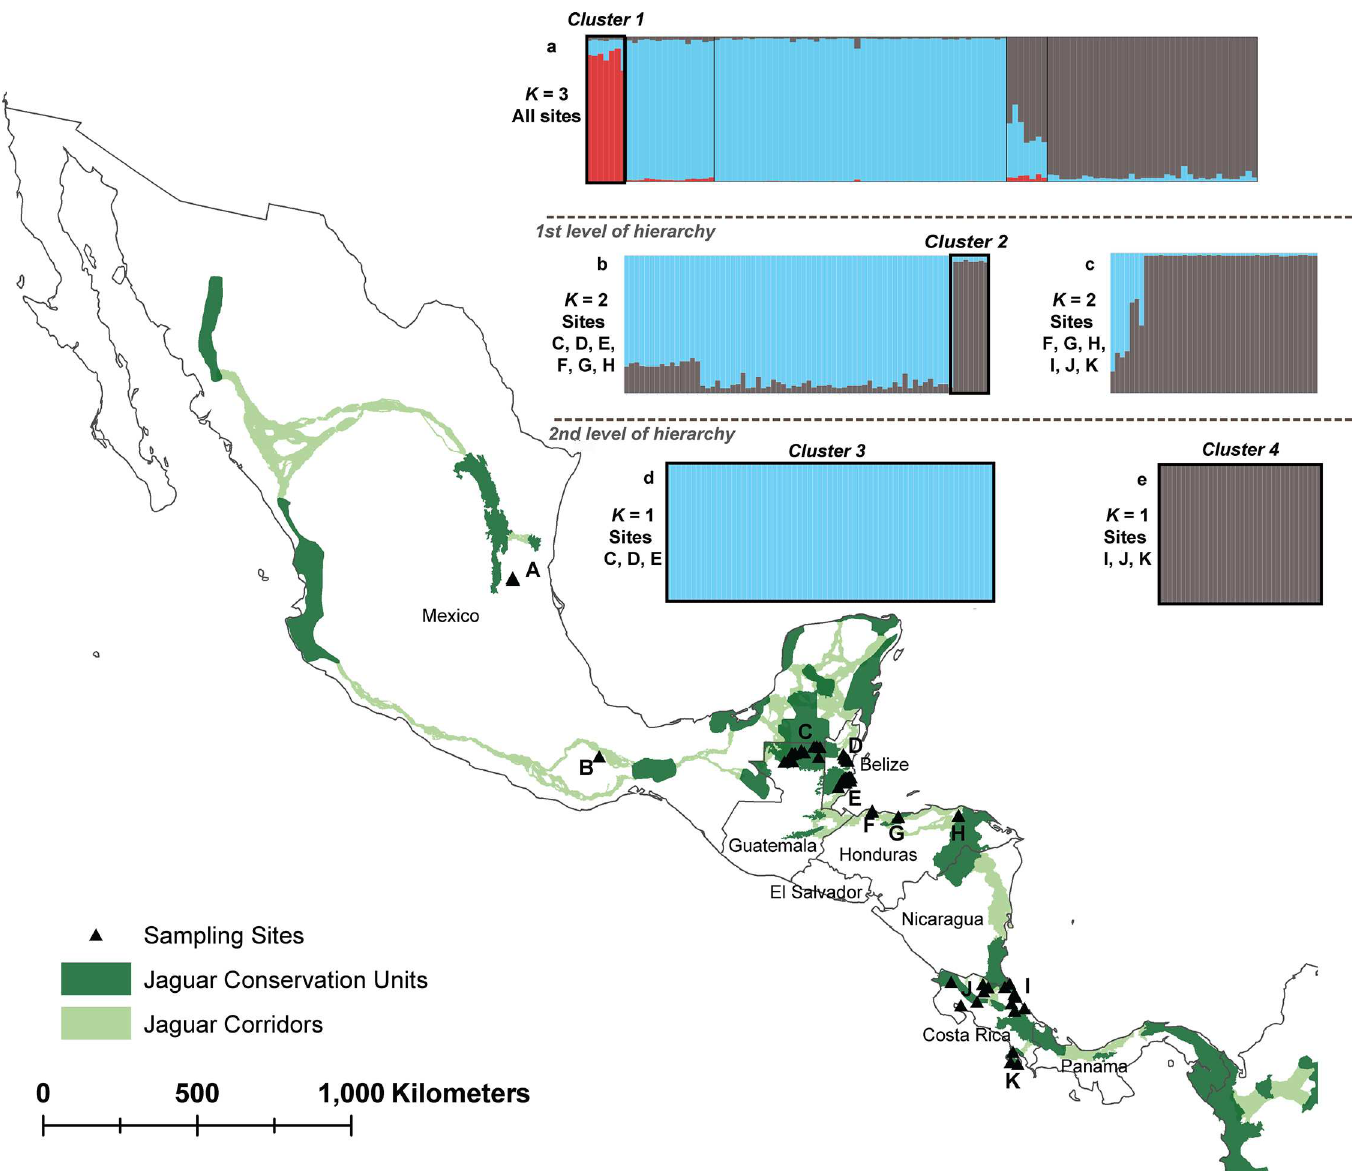
Fig 4. Hierarchical genetic structure in Mesoamerican jaguars. Bayesian clustering analysis was conducted for all jaguar samples (a, n = 115) at a first (b, n = 72; c, n = 42) and a second hierarchy level (d, n = 65; e, n = 36) using STRUCTURE, version 2.3.4 [47]. Hierarchicalstructure analysisidentifiedfour genetic clusters (cluster 1: sites A and B; cluster 2: sites F, G, and H; cluster 3: C, D, and E; cluster 4: I, J, and K). A, Sierra del Abra Tanchipa Biosphere Reserve, Mexico; B, Sierra Mixe, Oaxaca, Mexico; C, northern Guatemala (Lagunadel Tigre NationalPark, Maya Biosphere Reserve, Mirador R ı´ o-Azul NationalPark); D, Central Belize Corridor Area, Belize; E, Cockscomb Basin Wildlife Sanctuary, Belize; F, Jeanette Kawas NationalPark, Honduras; G, Pico Bonito NationalPark, Honduras; H, Rı´o Pla´tano Biosphere Reserve, Honduras; I, northeastern Costa Rica (Tortuguero NationalPark, Barra del ColoradoWildlife Refuge, and Barbilla NationalPark); J, several sites across northern and northwestern Costa Rica; K, Corcovado NationalPark, Costa Rica. K , number of genetics clusters inferred in